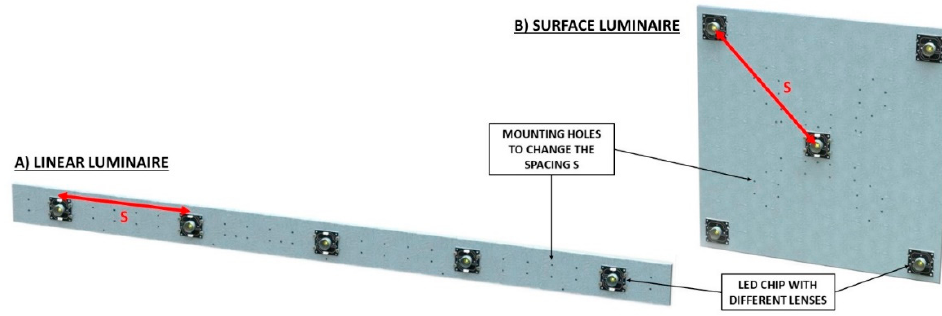
Figure 8. The views of the test luminaires: S—spacing between diodes.